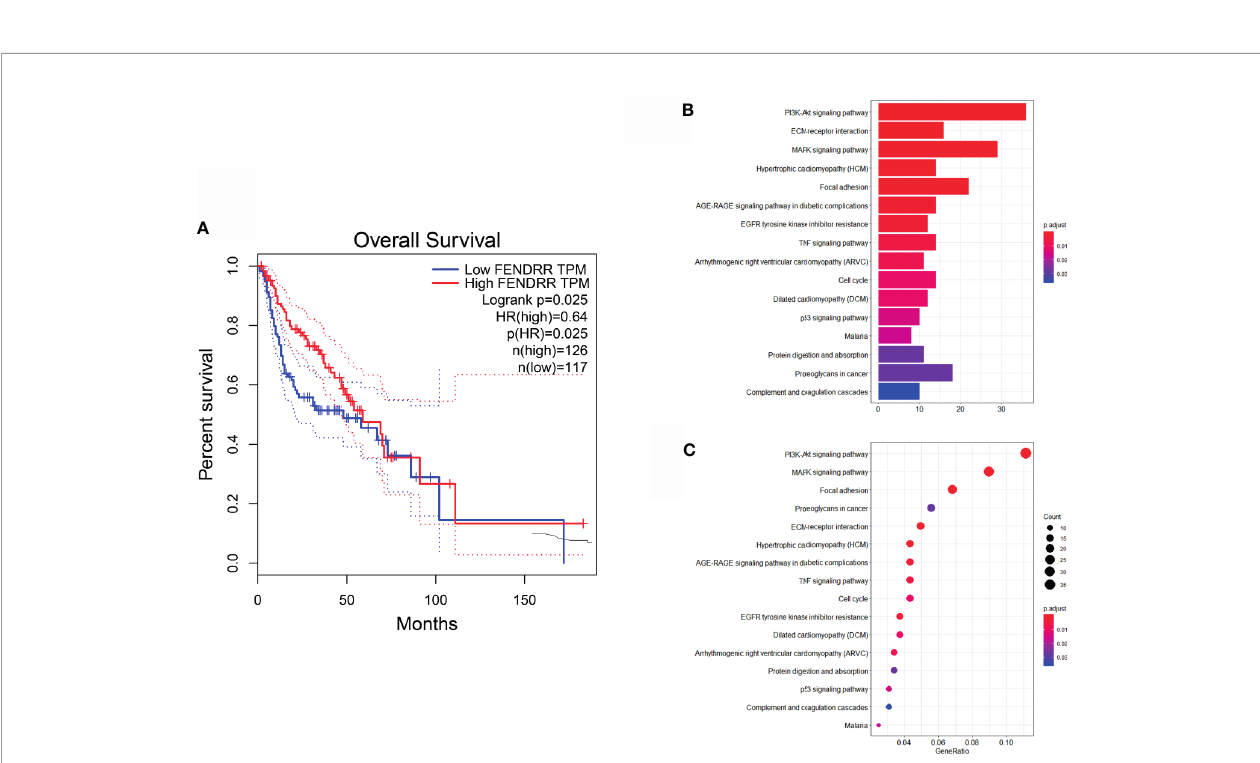
FIGURE 4 | Survival analysis and KEGG analysis. (A) Survival analysis showed that HNSCC patients with high expression of FENDRR have a better prognosis. (B, C) KEGG analysis showed that genes differentially expressed between CAFs and NFs derived from HNSCC patients are mainly enriched to the PI3K/AKT